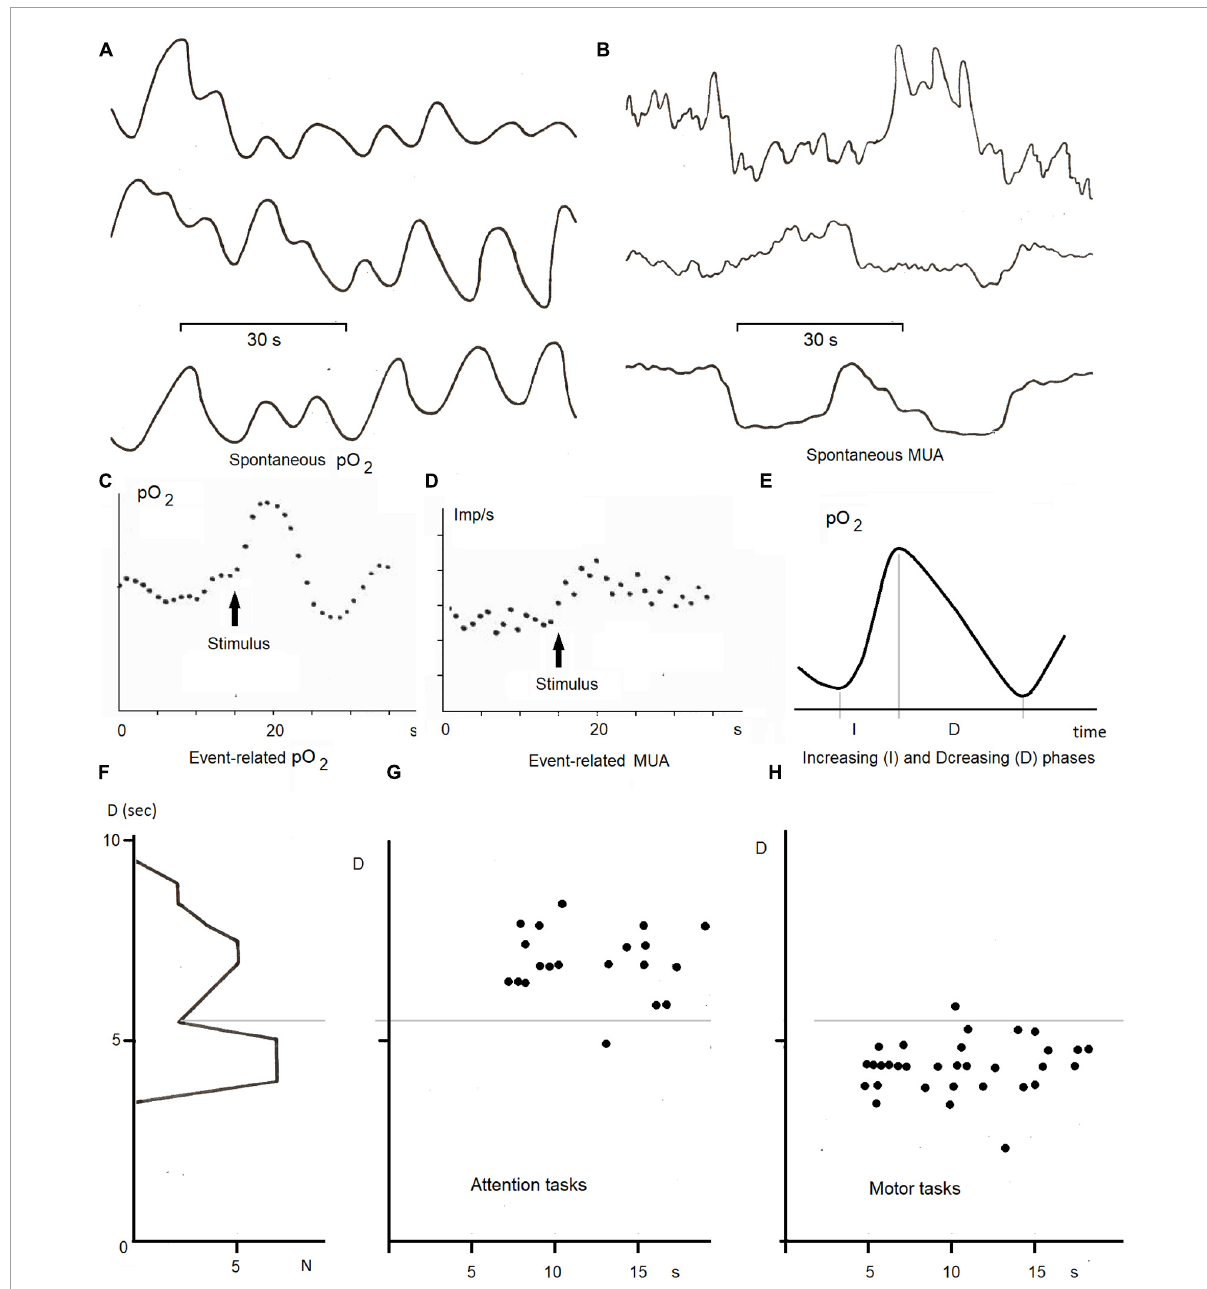
FIGURE6 ISFs of local pO 2 and multiunit activty (MUA) in the basal ganglia and thalamus in the neurological patients with gold electrodes implanted for diagnosis and therapy (adapted from Kropotov and Grechin, 1975; Gretchin and Kropotov, 1979; Kropotov, 1979). (A) Spontaneous infraslow oscillations (0.02—-0.1 Hz) of local pO 2 measured by the polarographic method from different electrodes; (B) spontaneous multi-unit activity recorded from different electrodes; (C) an averaged event-related pO 2 in the ventral thalamus in response to ten trials of the arithmetic task, (D) a post-stimulu time histogram of MUA in the same task, (E) a method of analysis of infra-slow oscillations by measuring duration of increasing (I) and decreasing (D) phases of local pO 2 , (F) histogram of D parameter of pO 2 oscillations in the ventral thalamus and its dynamics during 10 trials of the attention (G) and motor (H)